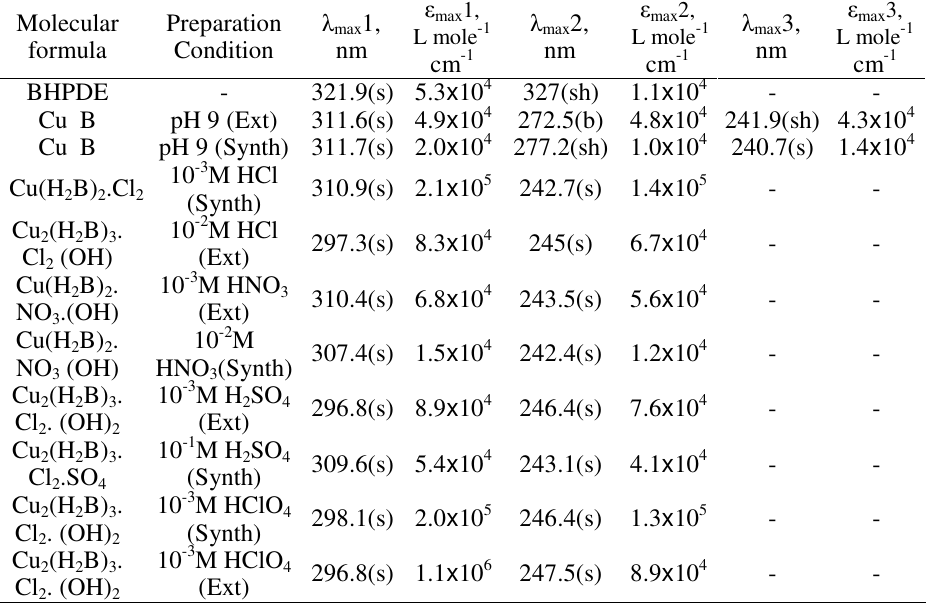
Table 2. Ultra-Violet spectra of BHPDE and its copper(II) complexes in chloroform Molecular Preparation formula Condition